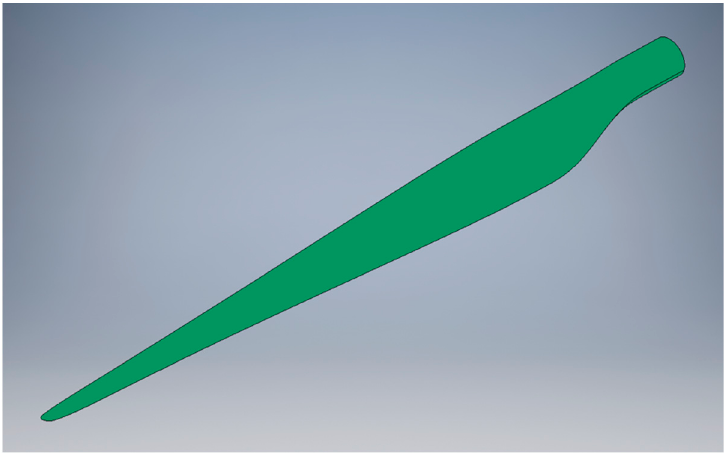
Figure 9. The 3D geometry of the wind tunnel model blade.